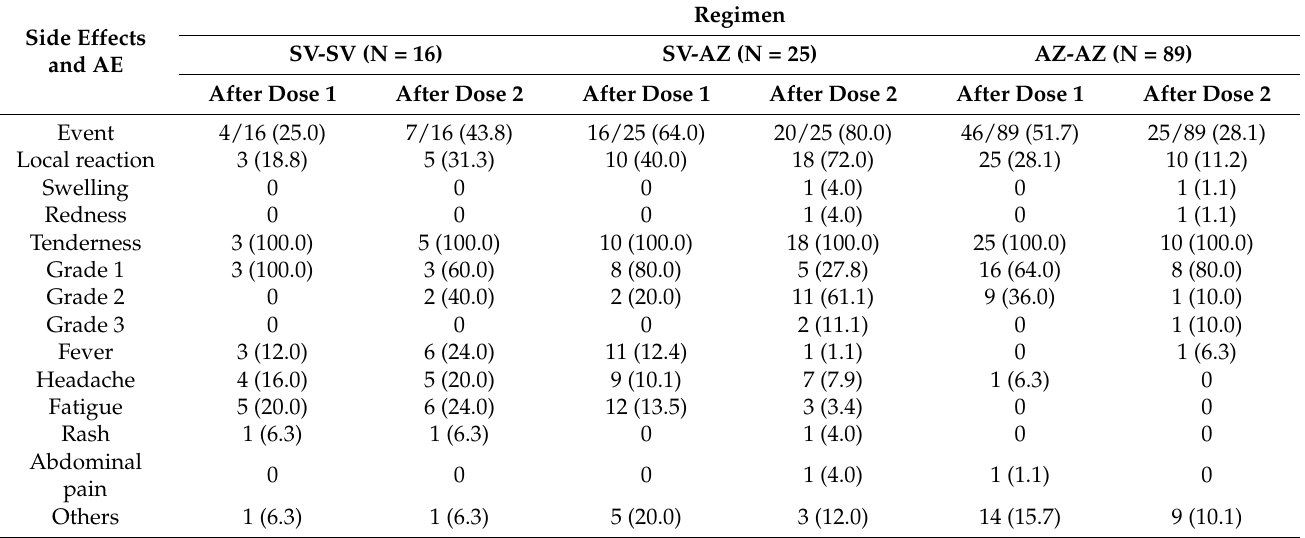
Table 4. Adverse events during the course of vaccination administration for each vaccine